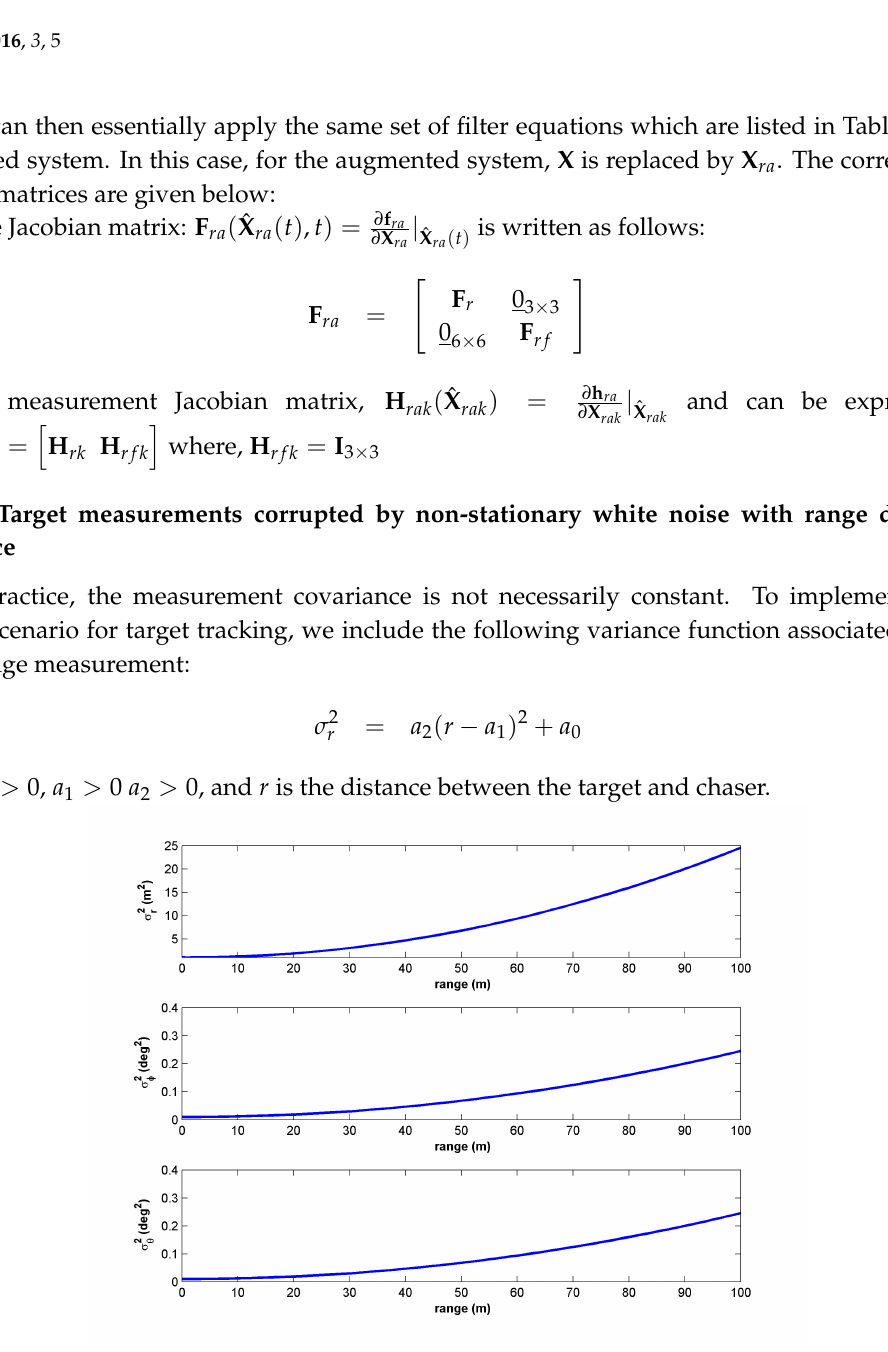
Figure 1. Measurement error variances as a function of the